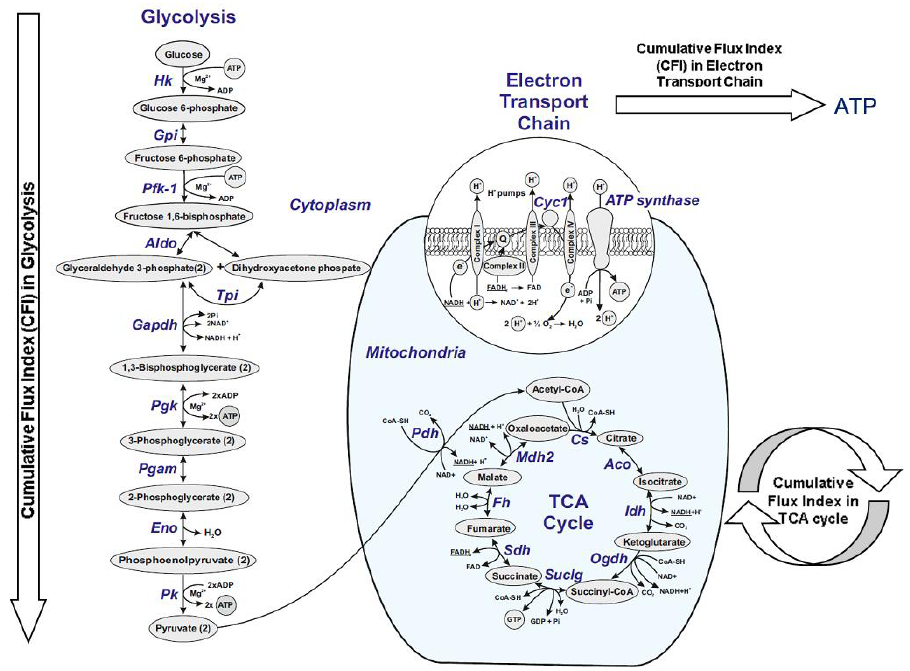
Figure 5. A schematic diagram of a general metabolic network including glycolysis, tricarboxylic acid (TCA) cycle and electron transport chain. The cumulative flux index (CFI) values were calculated as a parameter to integrate the reduced activity of the different enzymes in a specific network (glycolysis, TCA cycle and ATP generation by Electron Transport Chain (ETC), or together) as the expected total flux.